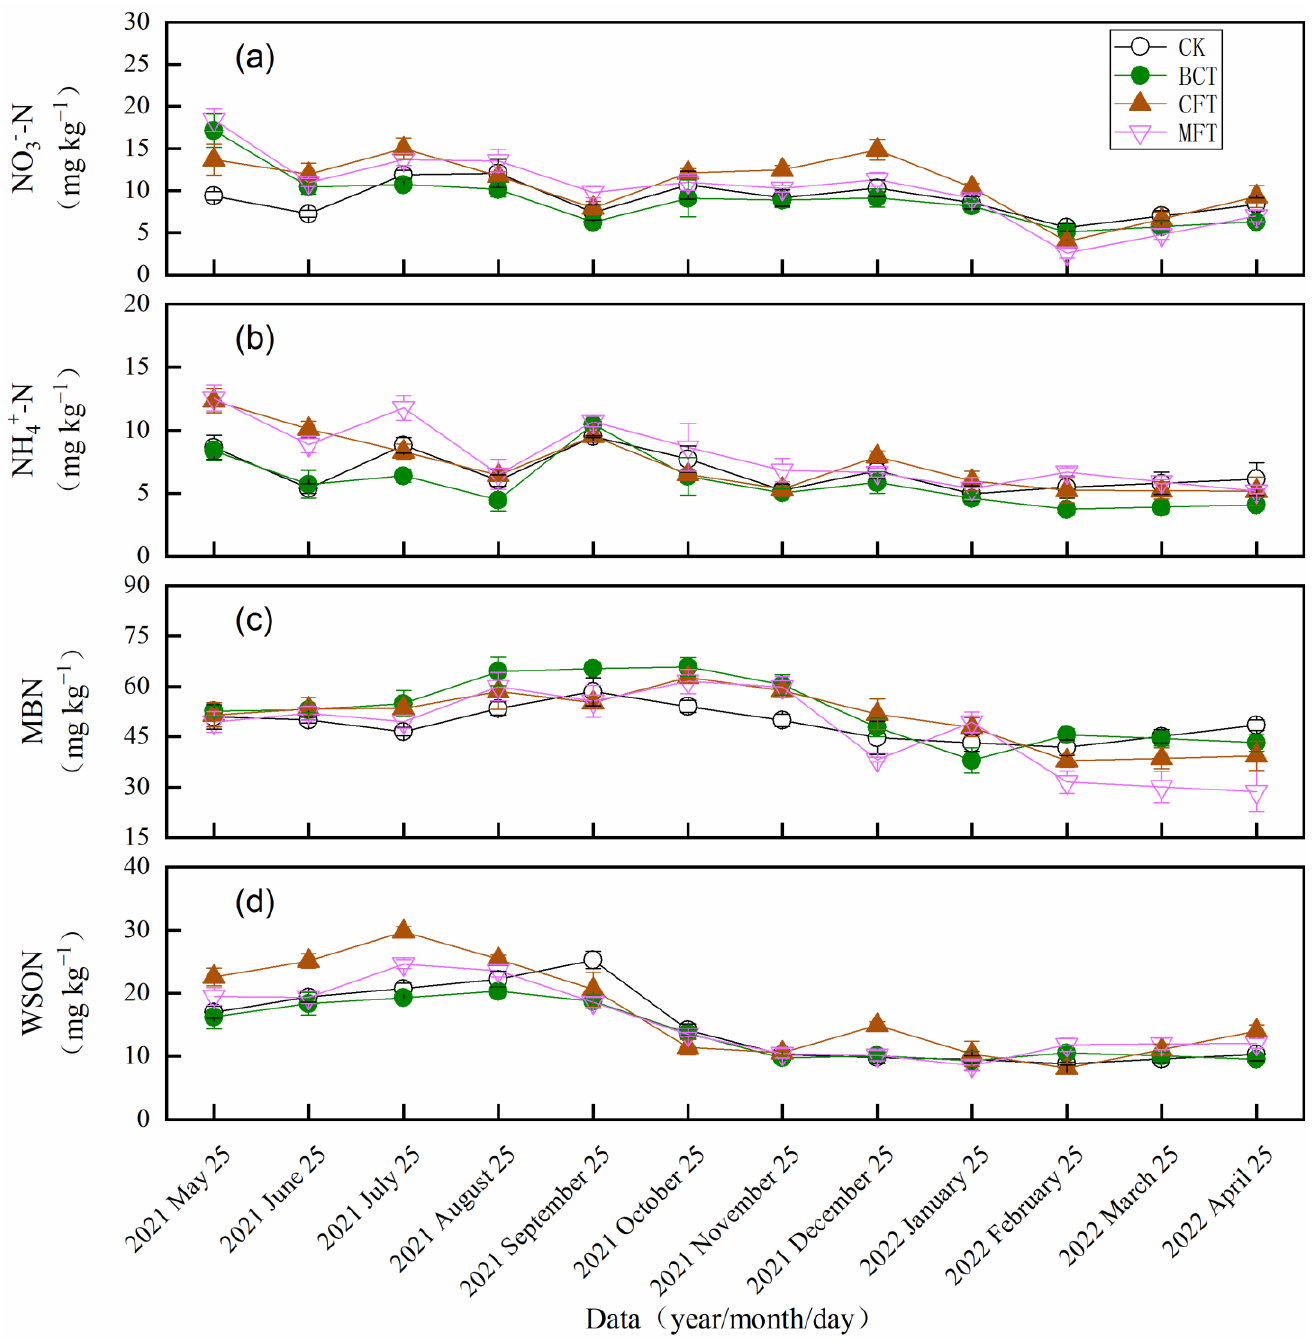
Figure 7. Effects of various fertilization strategies on ( a ) soil NO 3 − -N, soil ( b ) NH 4+ - N, soil ( c ) micro- bial biomass N (MBN), and soil ( d ) water-soluble organic N (WSON) concentration in the Pleioblastus amarus plantation. The standard deviation is indicated by vertical bars.